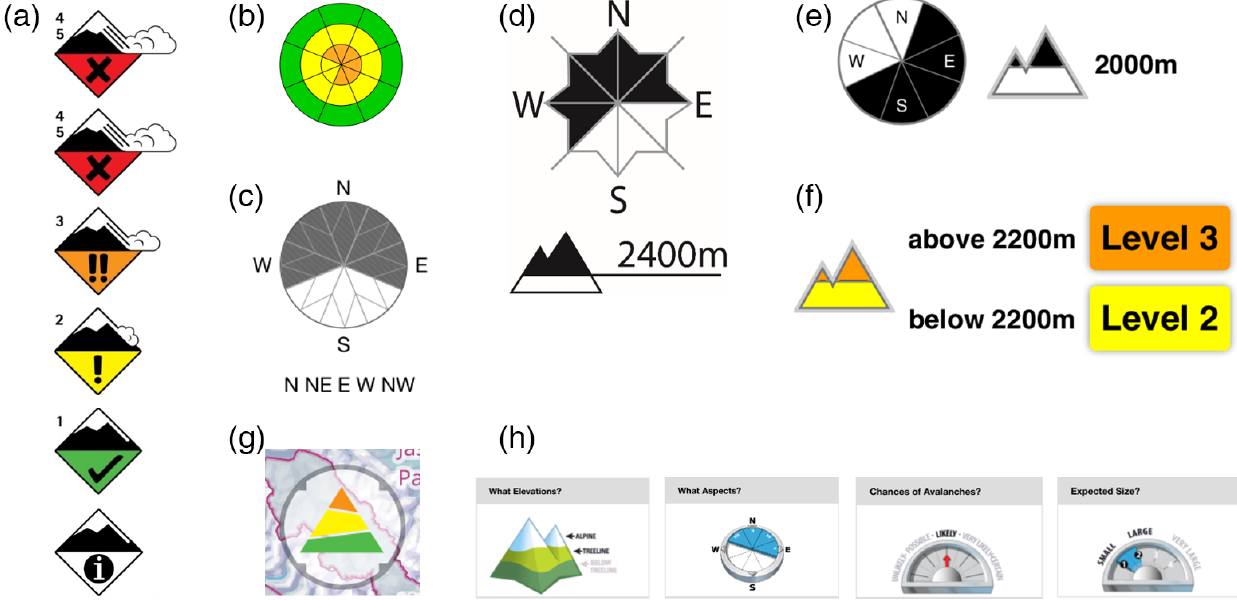
Figure 2. Icons used in the smartphone applications during the 2015–2016 winter season. (a) Avalanche danger scale used in apps 1, 3 and 6. (a) One icon to display danger levels according to elevation and slope aspects in app 2. (c) Slopes prone to avalanche in app 5. (d) The two icons used to inform on slope and elevation prone to avalanche in app 4. (e) Slope prone to avalanche icon in app 6. (f) Danger levels according to elevation in app 6. (g) Danger levels according to elevation in app 1. (h) Drawings used to characterize avalanche problems in app.